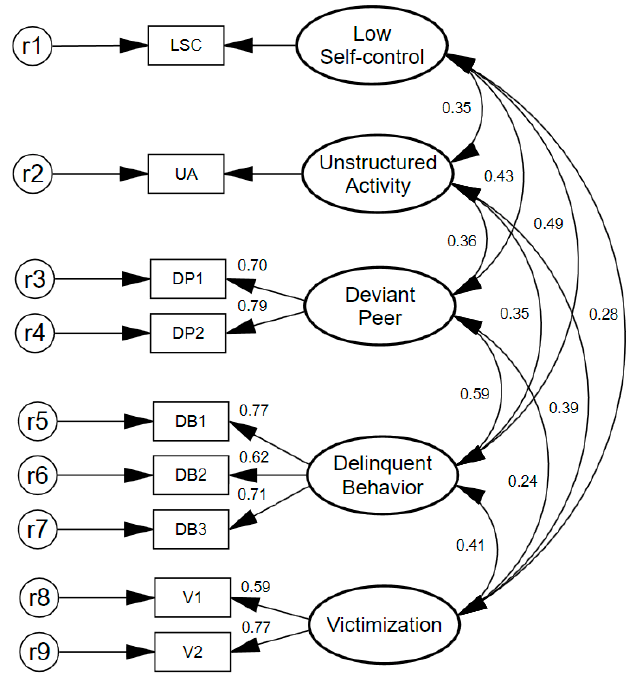
Figure 2. Measurement model for total sample with standardized coefficients (N = 1057). Circles represent latent constructs, and rectangles represent observed variables. χ 2 (19) = 78.291, p = 0.00, GFI = 0.984, CFI = 0.972, SRMR = 0.026, CN = 489, AIC = 130.291, and RMSEA = 0.054; 90% CI = [0.042, 0.067].